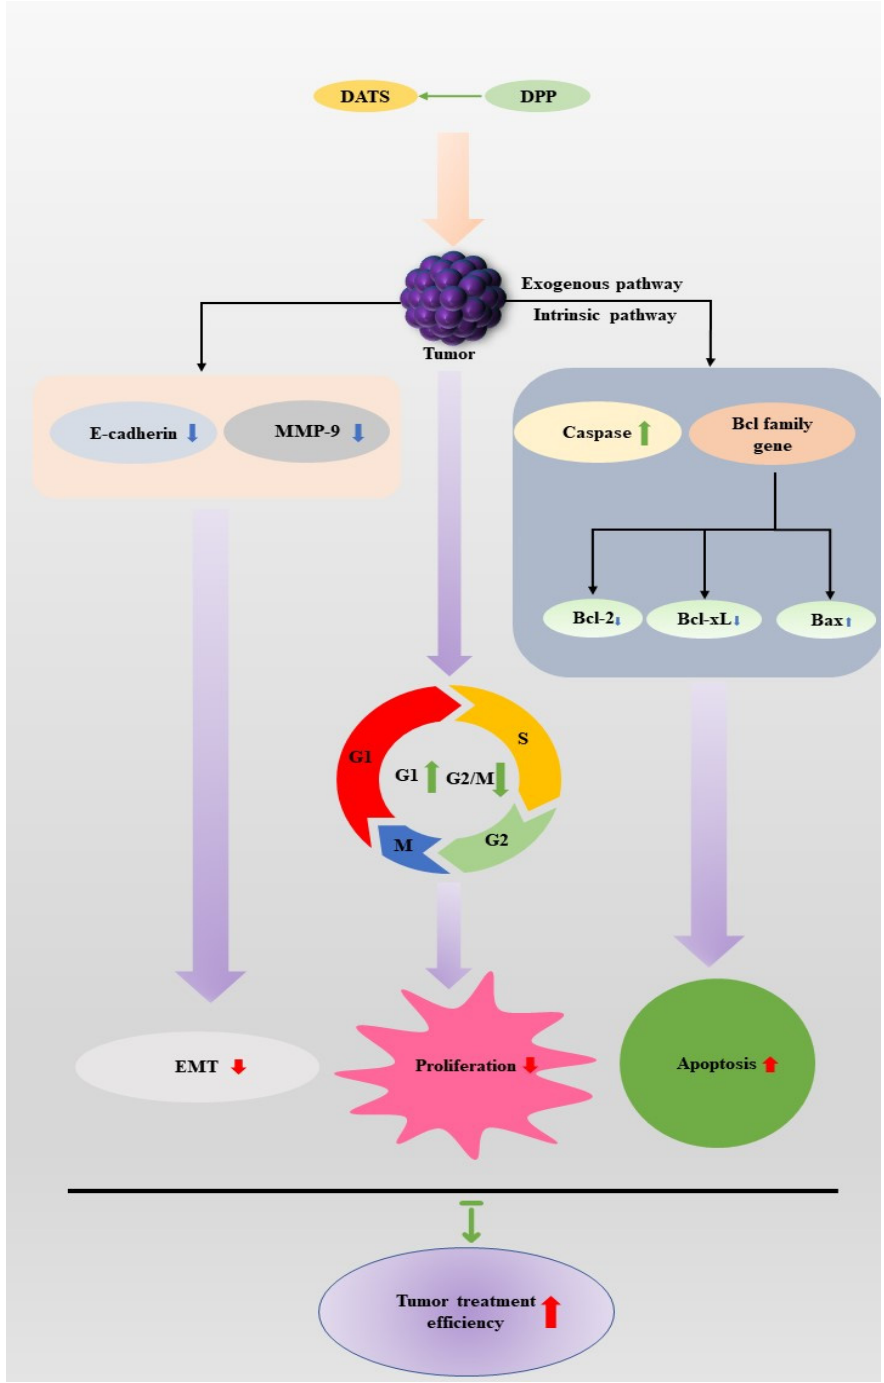
Figure 3. Therapeutic mechanism of DATS combined with DDP in lung cancer cells. When DATS is combined with DDP, DDP can enhance the activity of DATS. After DATS treatment of lung cancer tumors, the expression level of E-cadherin increased and the expression level of MMP-9 decreased, which inhibited the EMT process in tissues. At the same time, DATS activates caspases through endogenous and exogenous pathways and inhibits Bcl-family proteins, among which the expression level of pro-apoptotic factor Bax increases and the expression level of pro-growth factors Bcl-xl and Bcl-2 decreases, thus promoting the apoptosis of tumor cells. In addition, DATS increased the level of G1 phase and decreased the level of G2/M phase in tumor cells to inhibit the proliferation of tumor cells. Through the above process, the efficiency of lung cancer treatment can be improved. Abbreviations: DATS: diallyl trisulfide; DDP: